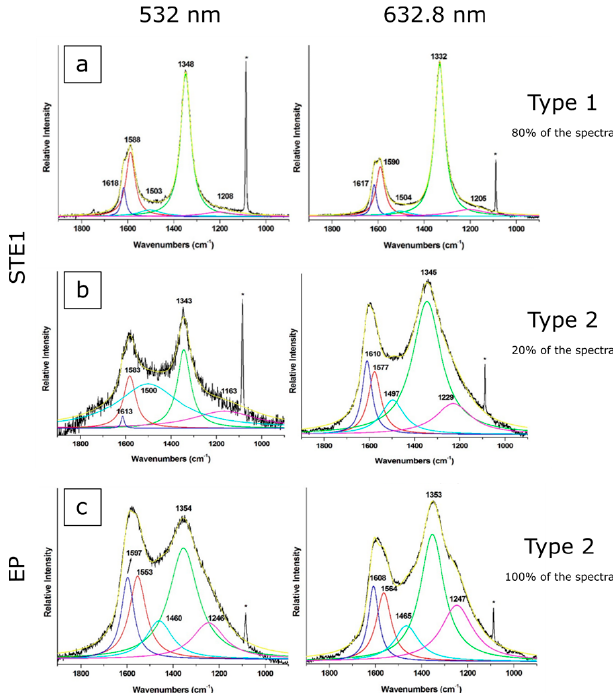
Figure 5. Typical spectrum types for STE1 and EP samples for 532 and 632.8 nm wavelength sources.